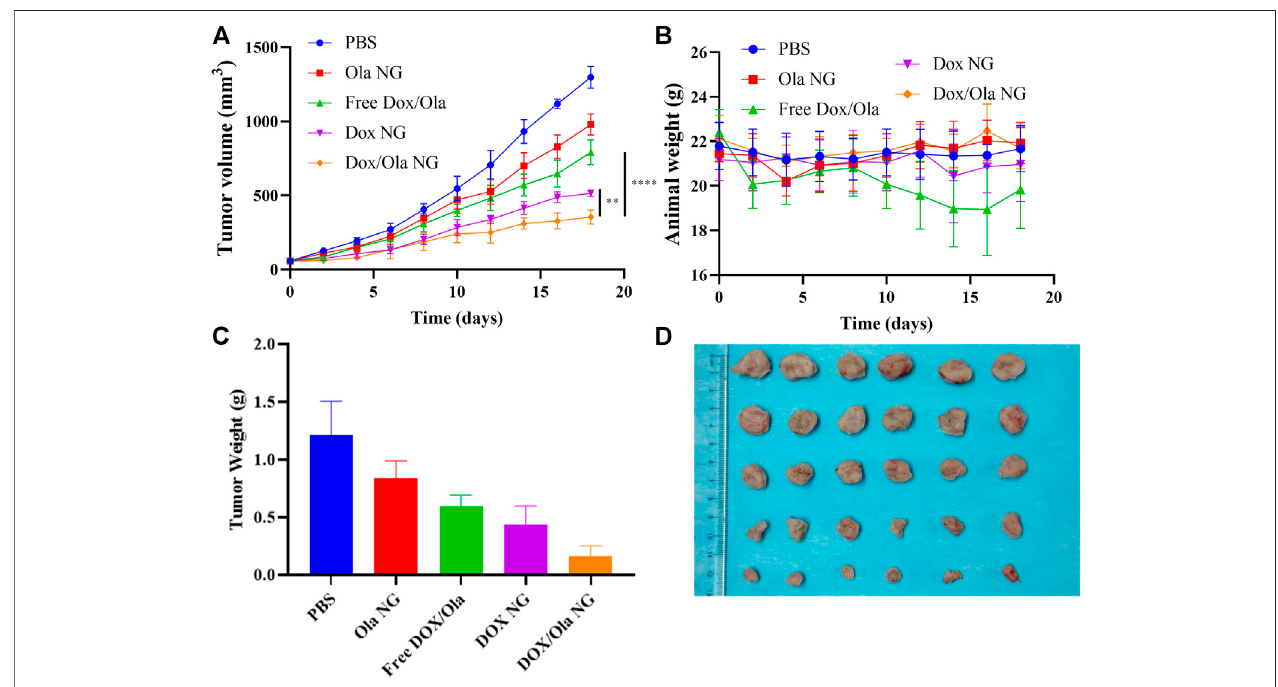
FIGURE 6 | In vivo tumor suppression effect. The changes of tumor volume (A) , body weight (B) , tumor weight (C) , and tumor tissue photos (D) of 4T1-bearing BALB/C mice treated with PBS, Ola NG, Free DOX/Ola, DOX NG, and DOX/Ola NG. Each set of data is represented as mean ± SD ( n =